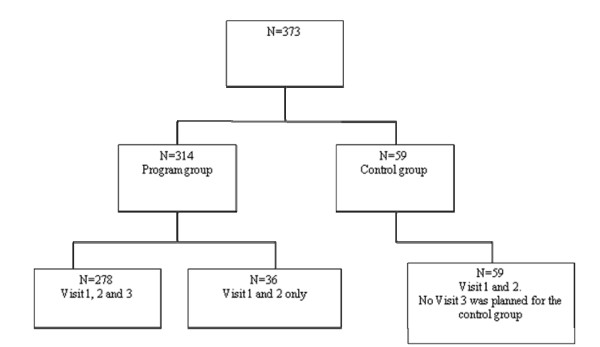
Participant flow.